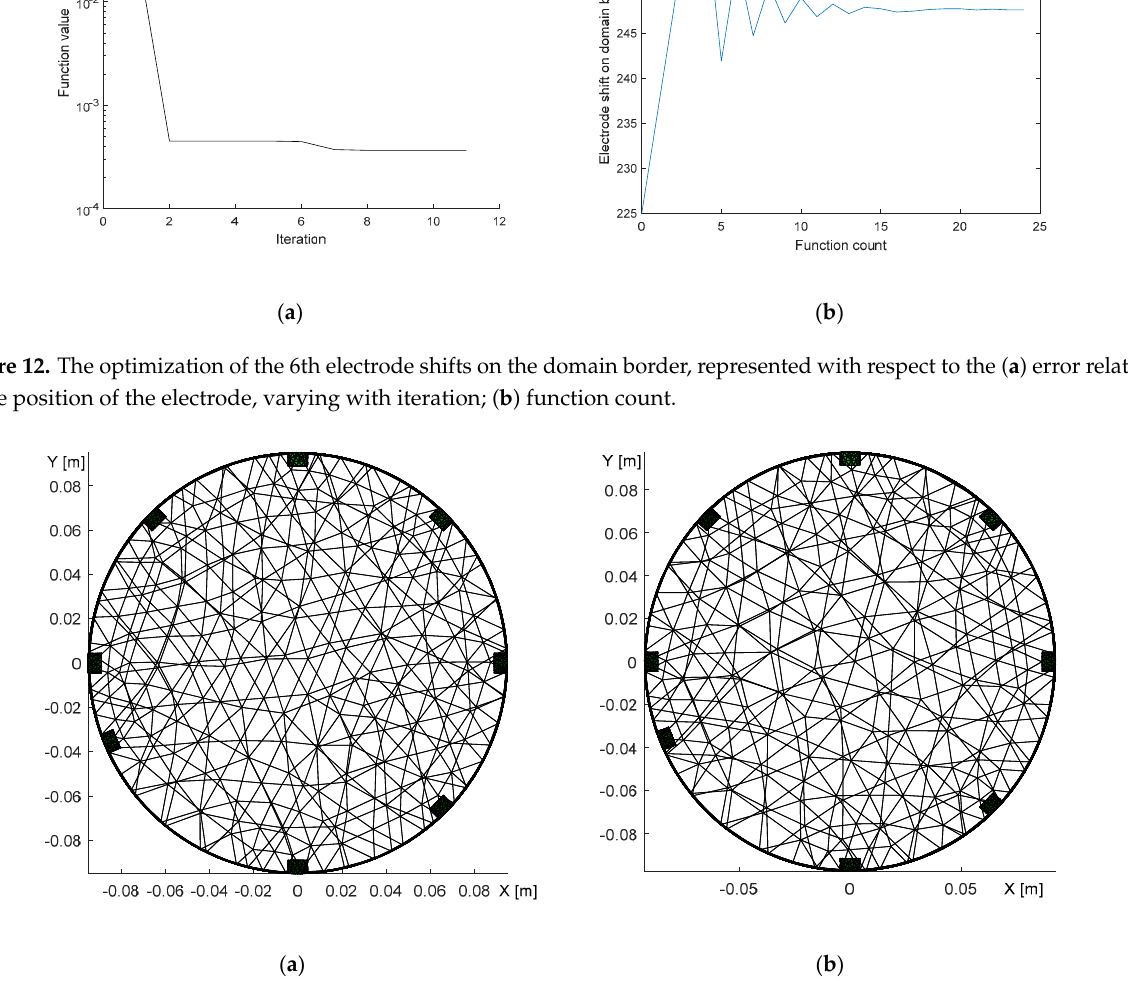
Figure 12. The optimization of the 6th electrode shifts on the domain border, represented with respect to the ( a ) error re- lated to the position of the electrode, varying with iteration; ( b ) function count.